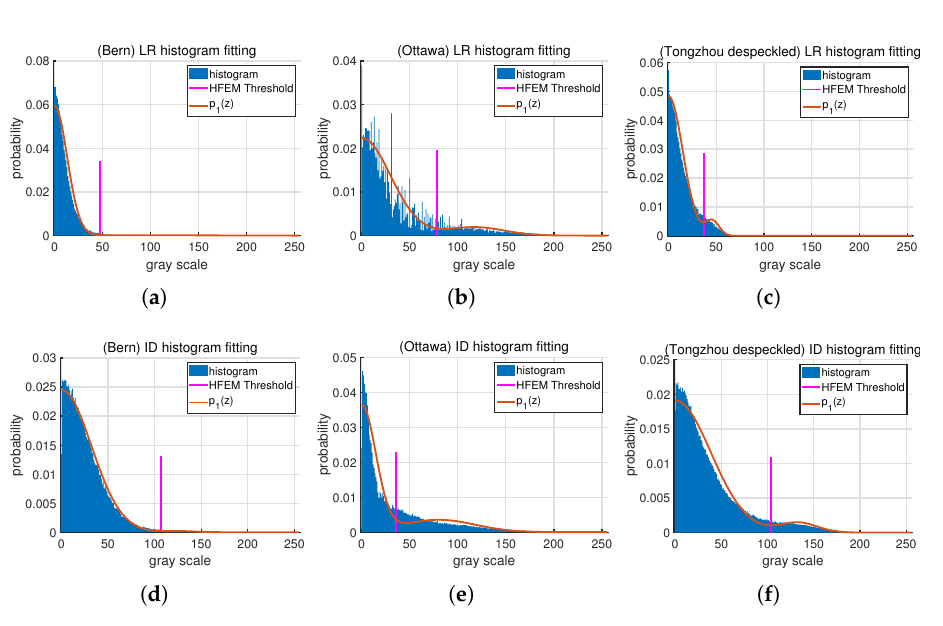
Figure A2. Histogram fitting of LR and ID for three datasets. ( a – c ) illustrate the histogram of LR for Bern, Ottawa and Tongzhou datasets, respectively. ( d – f ) illustrate the histogram of ID for Bern, Ottawa and Tongzhou datasets,